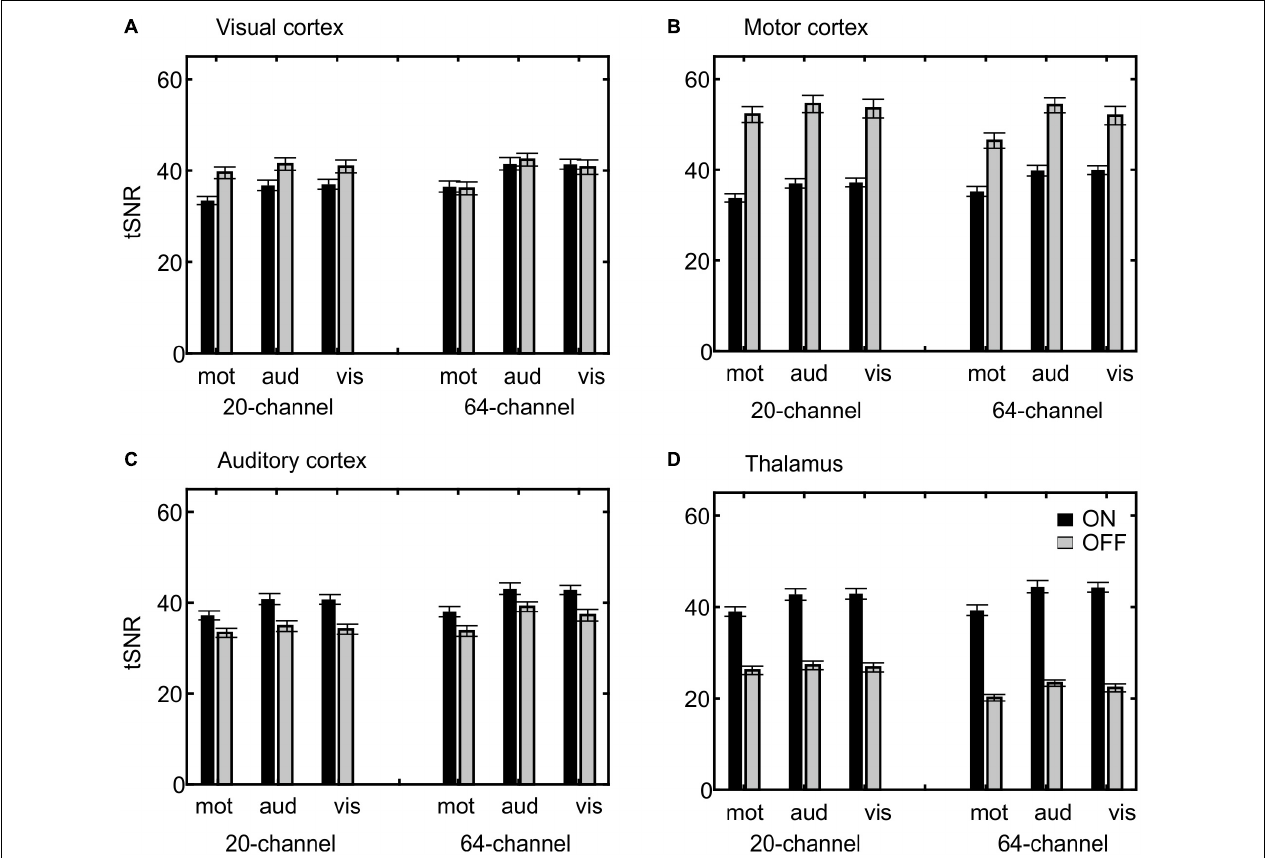
FIGURE 5 | Visualization of the ROI × head coil × task × prescan normalize interaction of the tSNR ROI analyses. Individual subfigures show the results for the different ROIs separately for the different head coils (left 20-channel, right 64-channel), tasks (motor, auditory, and visual) and the prescan normalize filter ON (black) and OFF (gray). Results for the visual (A) and motor cortex (B) are comparable and in contrast to the auditory cortex (C) and thalamus (D) , with a larger tSNR for prescan normalize OFF and with stronger differences between ON and OFF in the 20-channel head coil compared with the 64-channel head coil. In the (C) auditory cortex, there was a higher tSNR for the 64-channel head coil and the prescan normalize ON. In contrast, the (D) thalamus showed the similar pattern for the prescan normalize ON but higher tSNR in the 20-channel head coil. ROI, region of interest; tSNR, time-course signal-to-noise ratio.